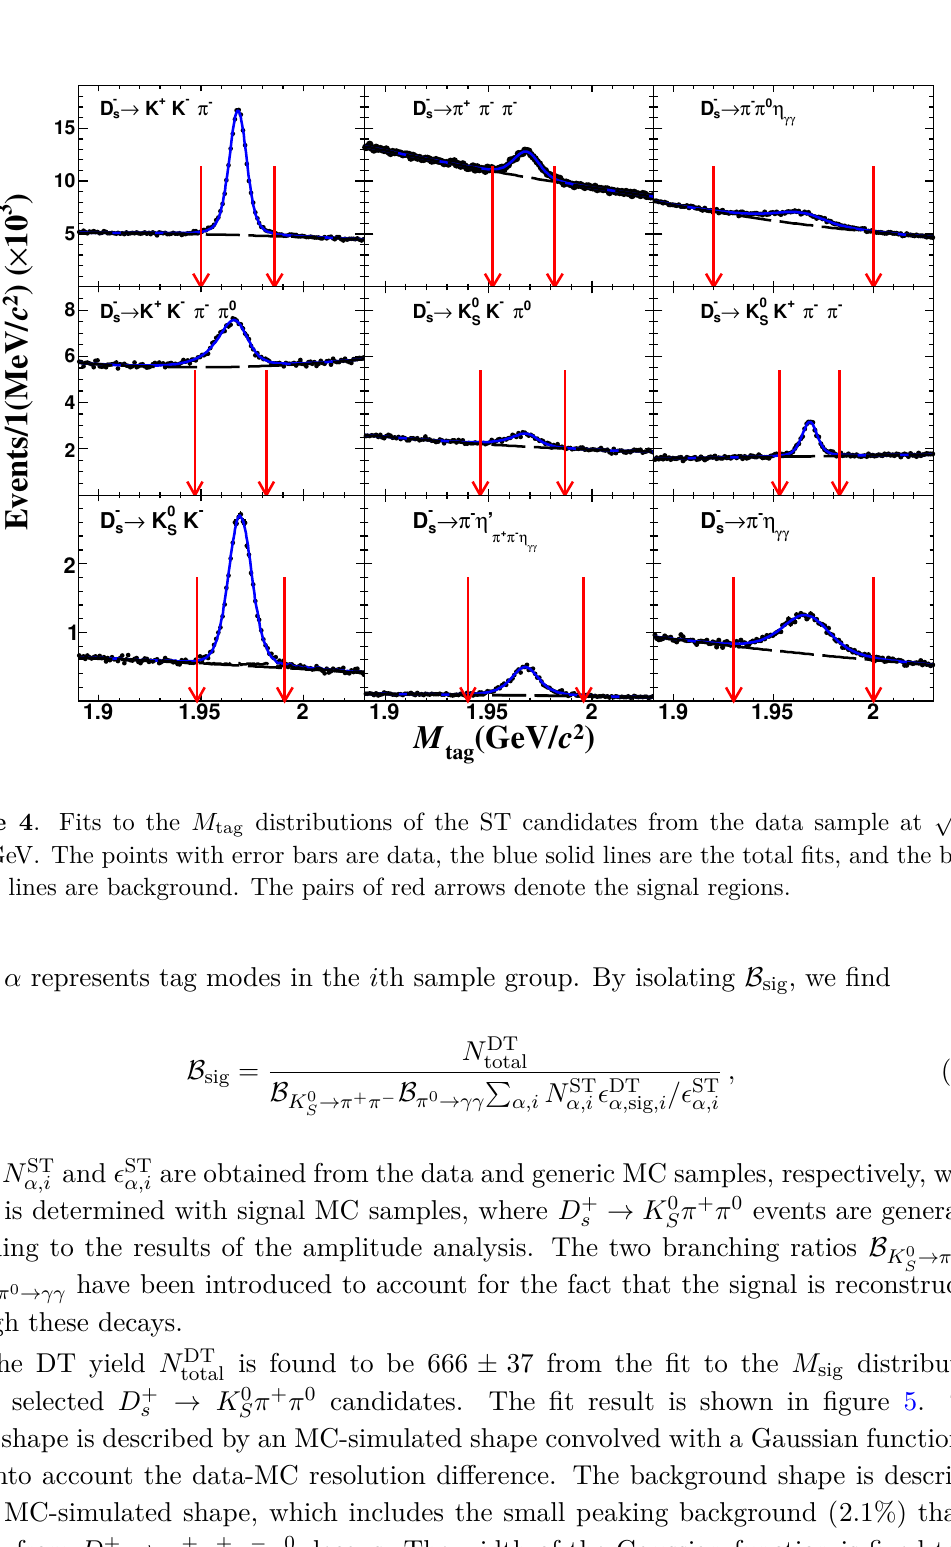
Figure 4 . Fits to the M tag distributions of the ST candidates from the data sample at 4 . 178 GeV. The points with error bars are data, the blue solid lines are the total fits, and the black dashed lines are background. The pairs of red arrows denote the signal